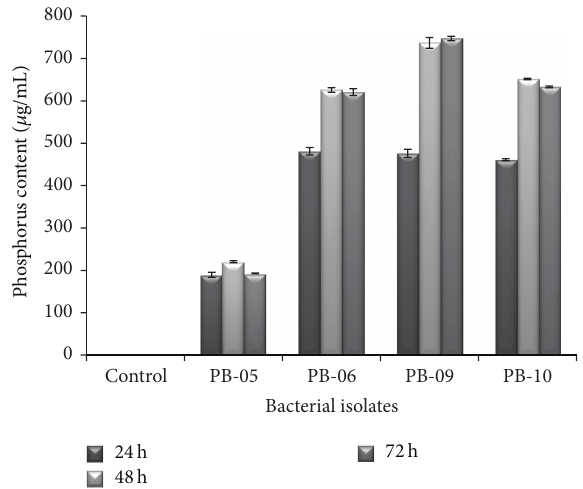
Figure 2: Effect of time on IAA production by bacterial isolates.